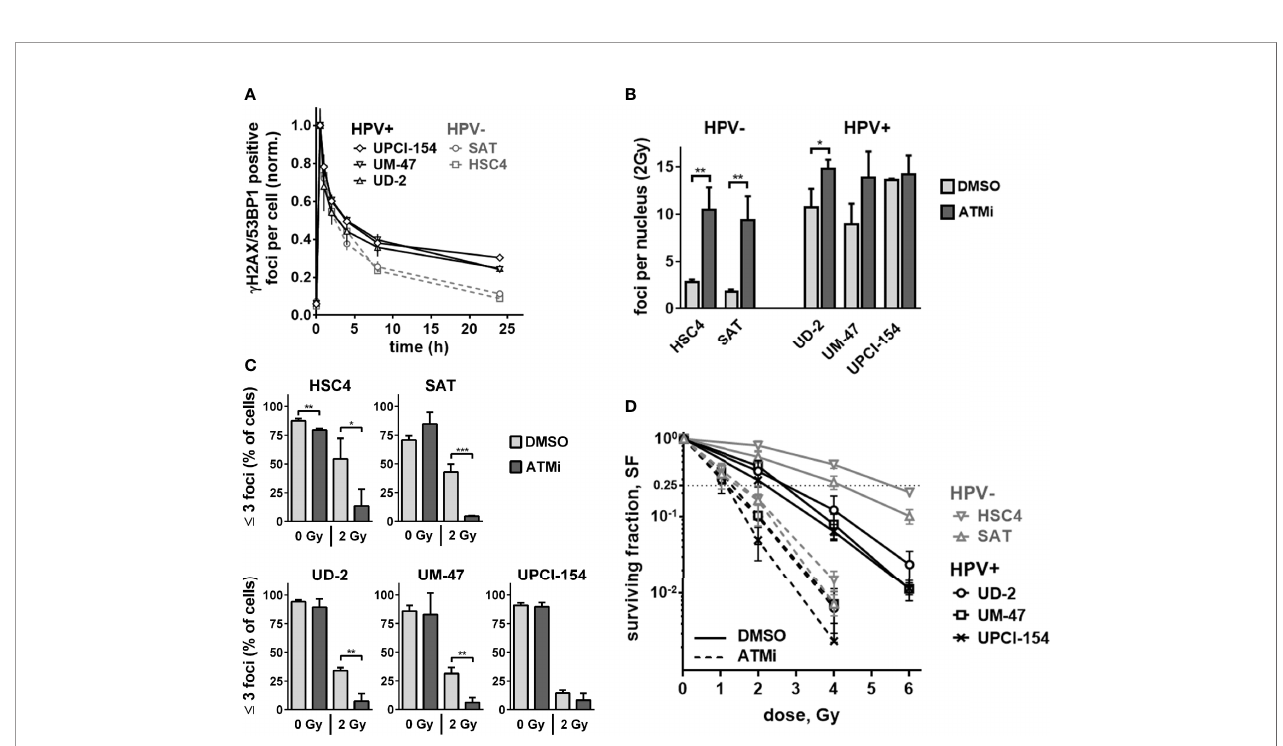
FIGURE 3 | Residual double-strand breaks and radiation sensitivity. (A) DSB repair kinetics of HPV+ and HPV − HNSCC cell lines. For each cell line, the values for nuclear foci were normalized to the fi rst time point (30 min) after irradiation with 2 Gy. (B) Quanti fi cation of nuclear g H2AX foci at 24 h after 2 Gy irradiation with and without ATM inhibition. Counts of the respective non-irradiated controls were subtracted. (C) Fraction of cells with three or less nuclear g H2AX foci at 24 h after 0 or 2 Gy. (D) Cell survival as determined by colony formation assays with and without ATM inhibitor treatment. In (B – D) cells were generally treated with ATM inhibitor or solvent 30 min prior to and for 24 h after irradiation. In (B, C) , S phase cells (EdU+, Geminin+) were excluded from quanti fi cation. In the case of UM-SCC-47, 53BP1 foci were assessed instead of g H2AX. Statistical evaluation was performed for changes upon ATM inhibition in (B, C) , asterisks depict signi fi cant differences with *, ** and *** indicating p < 0.05, p < 0.01 and p < 0.001, respectively (two-tailed Student ’ s